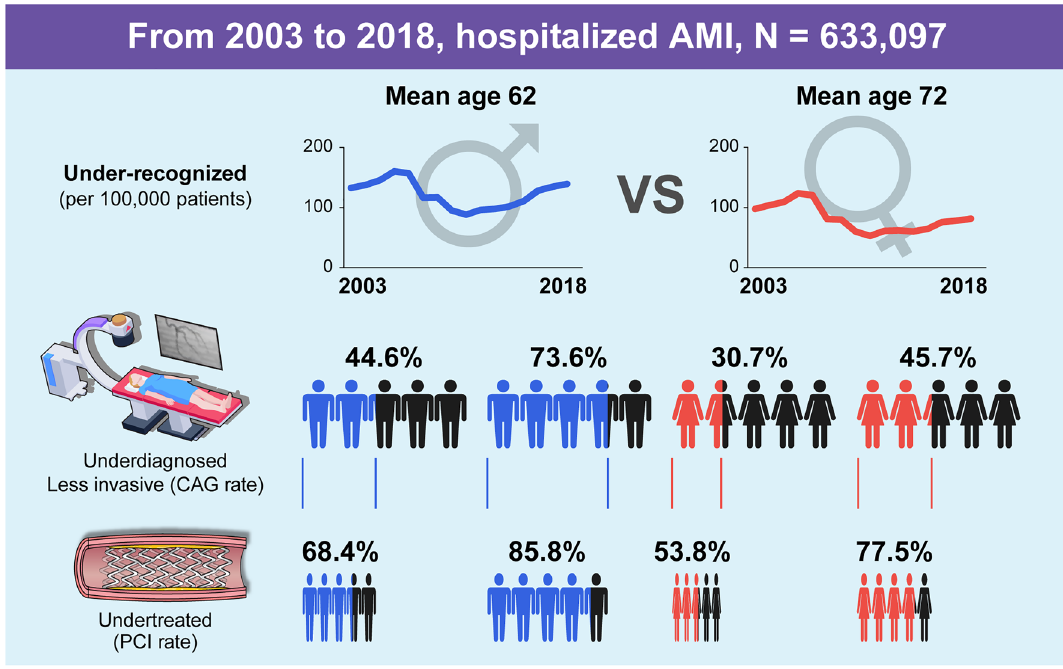
Figure 1. Incidence, CAG, and PCI rate of patients with AMI by gender from 2003 to 2018 according to the Korean National Health Insurance Claims Database. The CAG rate was defined as the proportion of patients diagnosed with AMI who also underwent CAG compared to the number of patients diagnosed with the disease. The PCI rate was defined as the proportion of patients diagnosed with AMI who underwent PCI against the number of patients diagnosed with the disease and undergoing CAG. Abbreviations: AMI, acute myocardial infarction; CAG, coronary angiography; PCI, percutaneous coronary